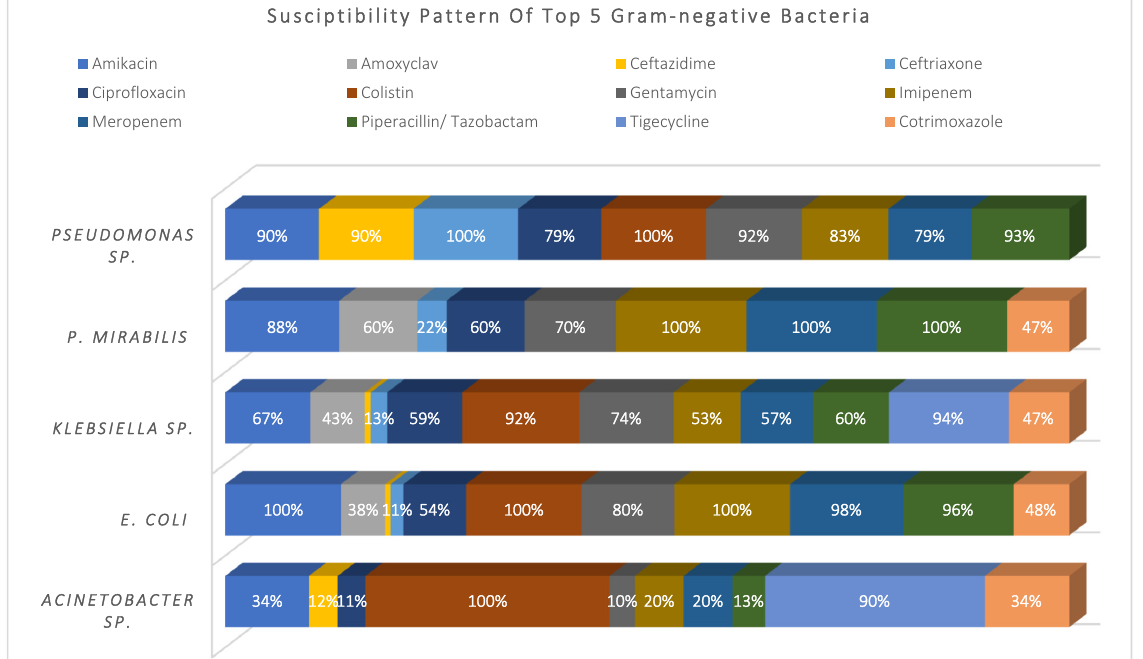
Figure 3. Susceptibility pattern of top 5 Gram-negative bacteria.